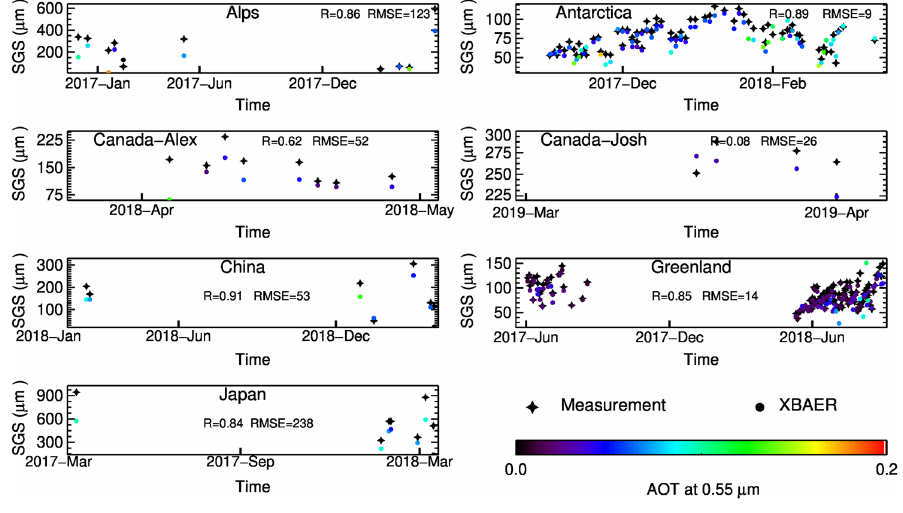
Figure 9. Time series of XBAER-derived and field-measured SGS for each site. The match-ups for SGS are distinguished by the AOT values. The correlation coefficient ( R ) and the RMSE (µm) are